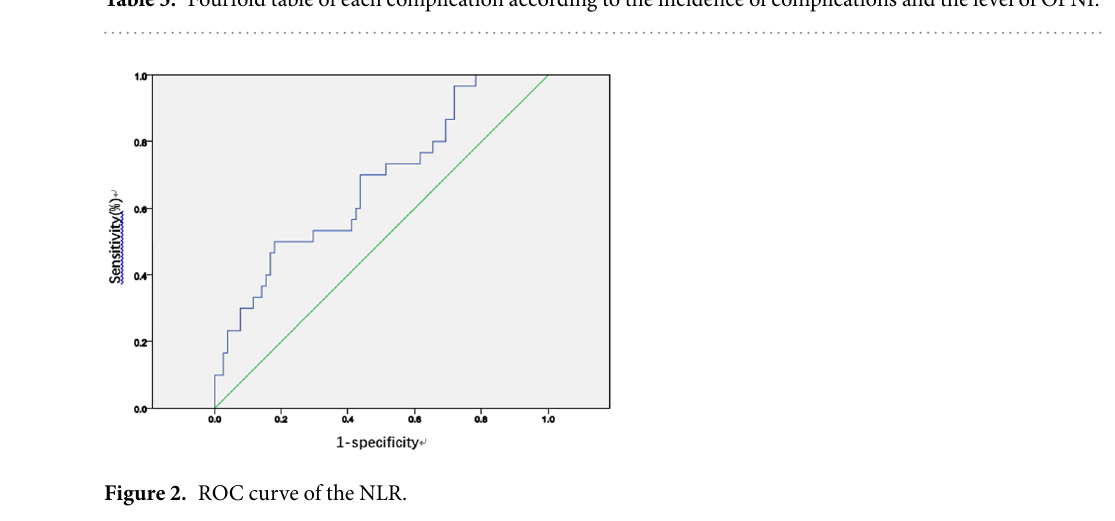
Table 5. Fourfold table of each complication according to the incidence of complications and the level of OPNI.